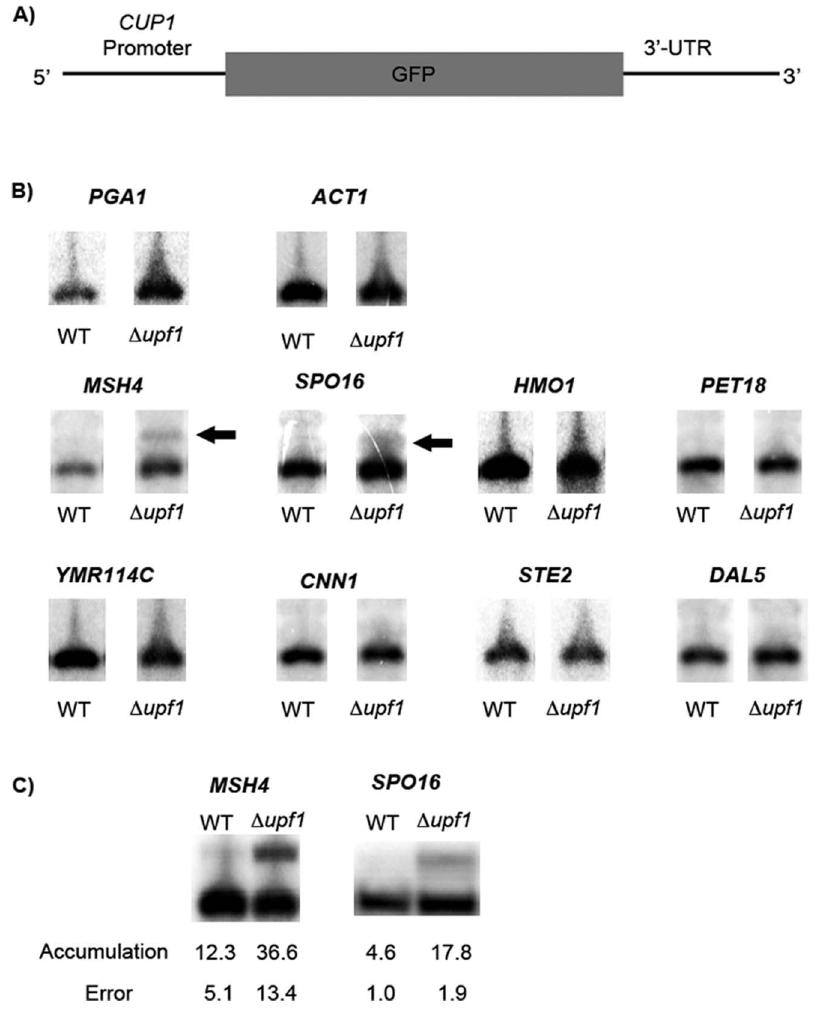
Figure 1. The 3 9 UTR of MSH4 and SPO16 produce transcription read-through products in an NMD dependent manner. ( A ) A reporter system was constructed on a centromeric plasmid. The reporter consisted of the 3 9 UTR of genes of interest fused to GFP under control of the copper inducible CUP1 promoter. ( B ) Eight genes were examined by northern blot in a BY4741 background with both a wild type and D upf1 strain. The 3 9 UTR of PGA1 is known to target transcripts for NMD and ACT1 is known to be insensitive to NMD. Both were included as controls [16]. Only the MSH4 3 9 UTR and SPO16 3 9 UTR displayed accumulation of a longer transcript, which are indicated by arrows. ( C ) The relative accumulation of the longer transcript was measured in a W303A background. Relative accumulation was calculated as the percentage of the longer transcript relative to total transcripts. Strain dependent differences in the magnitude of NMD-dependent accumulation in BY4741 and W303A background is consistent with previously published results [19]. All values are the result of averaging a minimum of 3 replicates.